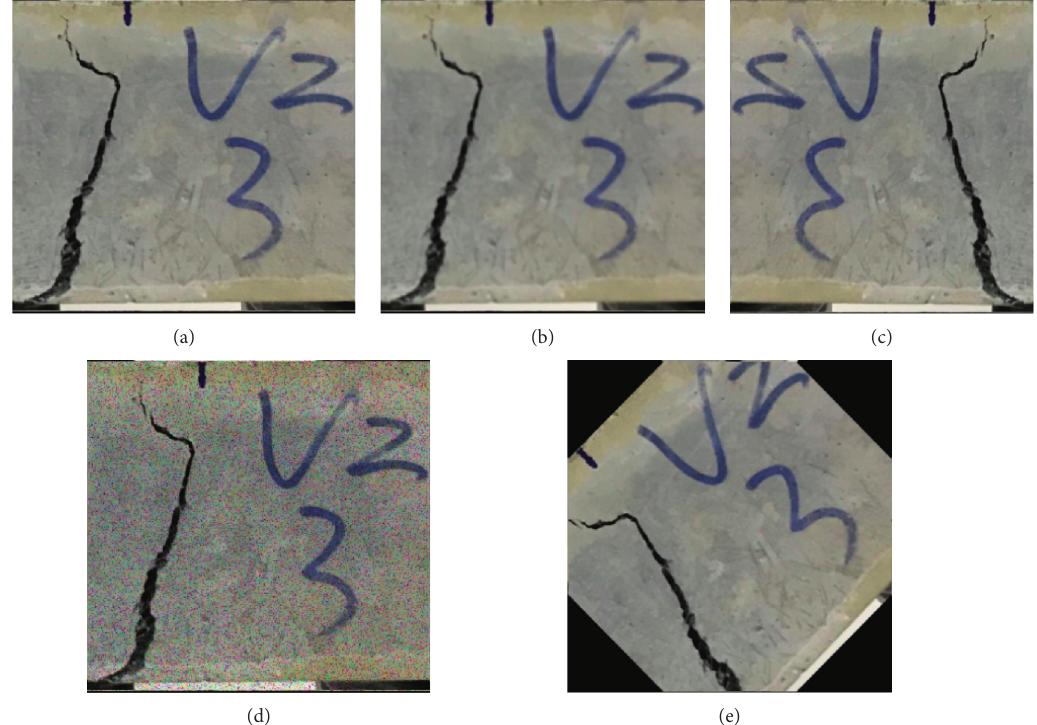
Figure 4: Crack image data augmentation. (a) Original picture. (b) Blurring. (c) Flipping. (d) Noise adding. (e)